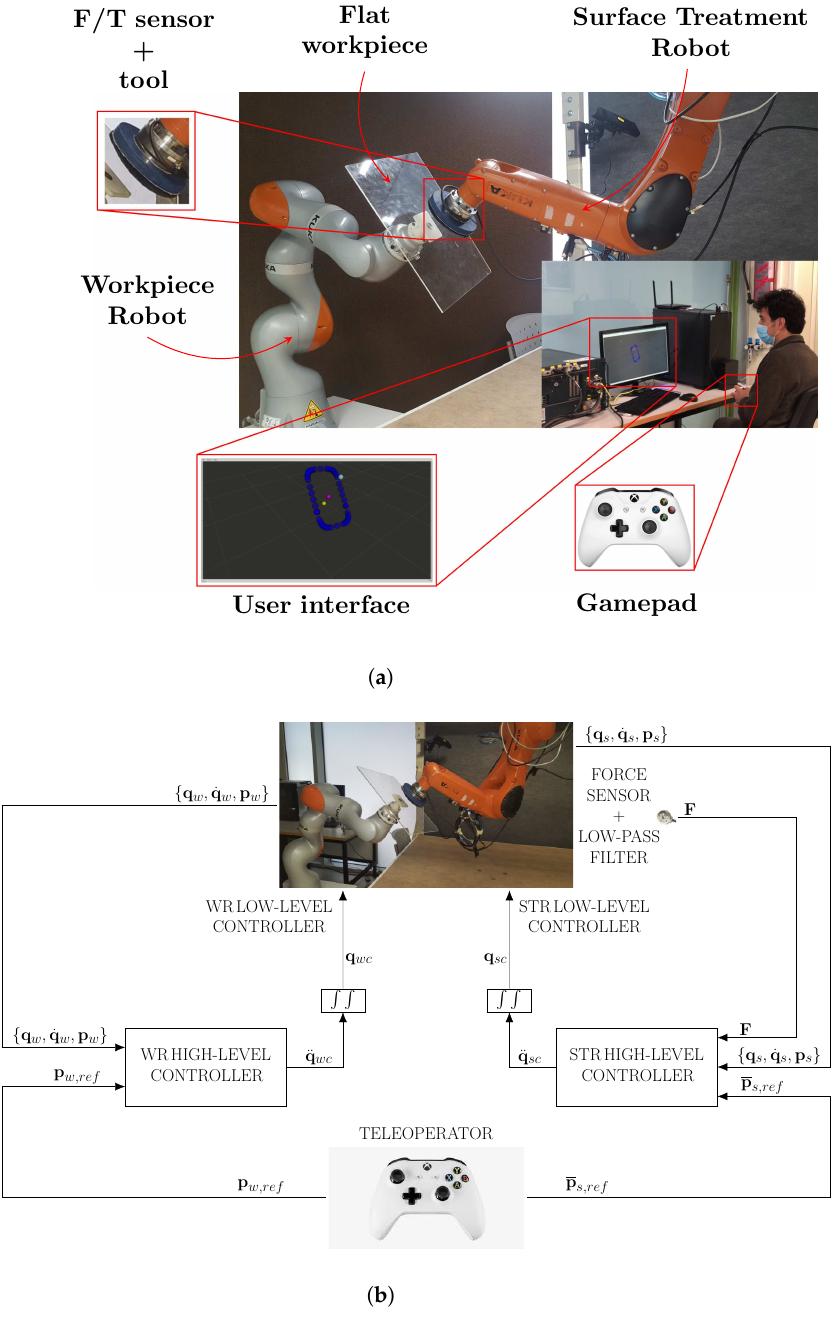
Figure 1. Bimanual application setup and block diagram (for further details, refer to [31]). ( a ) Previous setup used for the real experimentation. ( b ) Block control diagram for both robots (WR and